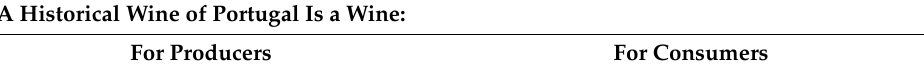
Table 1. Attributes of a wine classified as HWP identified from semi-structured interviews with Portuguese wine producers (n = 3) and consumers (n = 12).